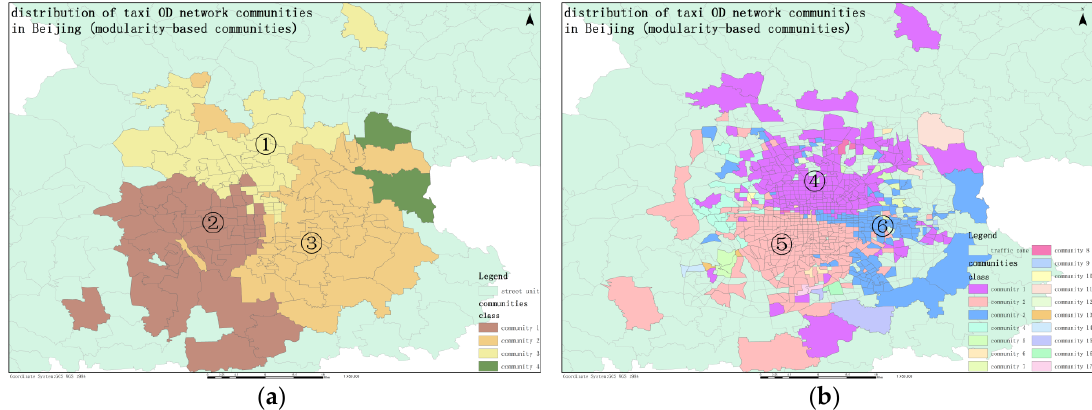
Figure 12. Taxi OD flow network communities based on ( a ) street unit and ( b ) traffic zone.